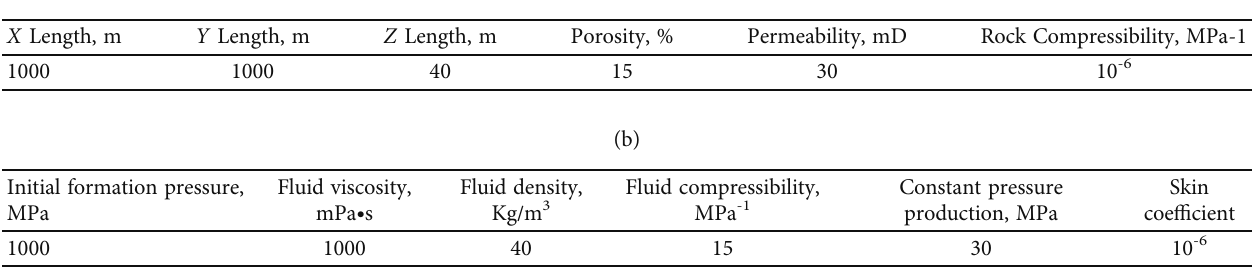
Table 1: Summary of basic reservoir